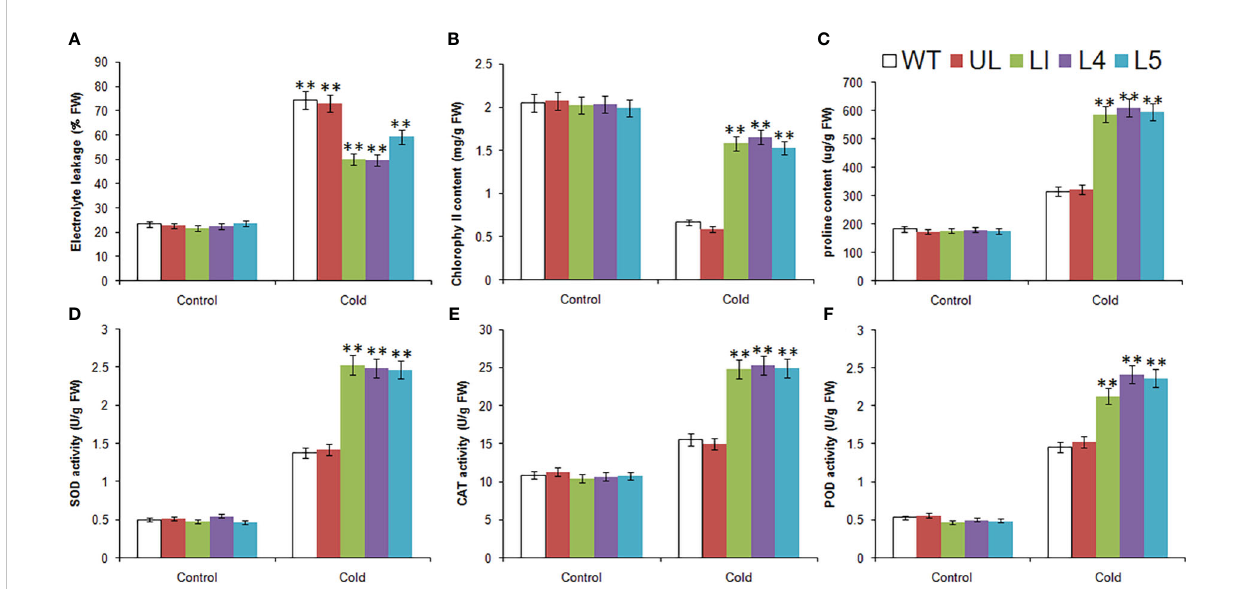
FIGURE 6 Physiological and biochemical indicatorsin MbMYBC1 -OE A. thaliana . (A) EL, (B) Chlorophyll content, (C) proline content, (D) SOD activities, (E) CAT activities, and (F) POD activities. (**, P ≤ 0.01).The control was the index in the WT. All data were the average of 3